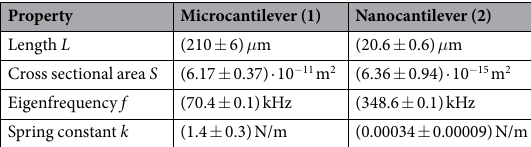
Table 1. Numerical values for the properties of micro- and nanocantilever before frequency